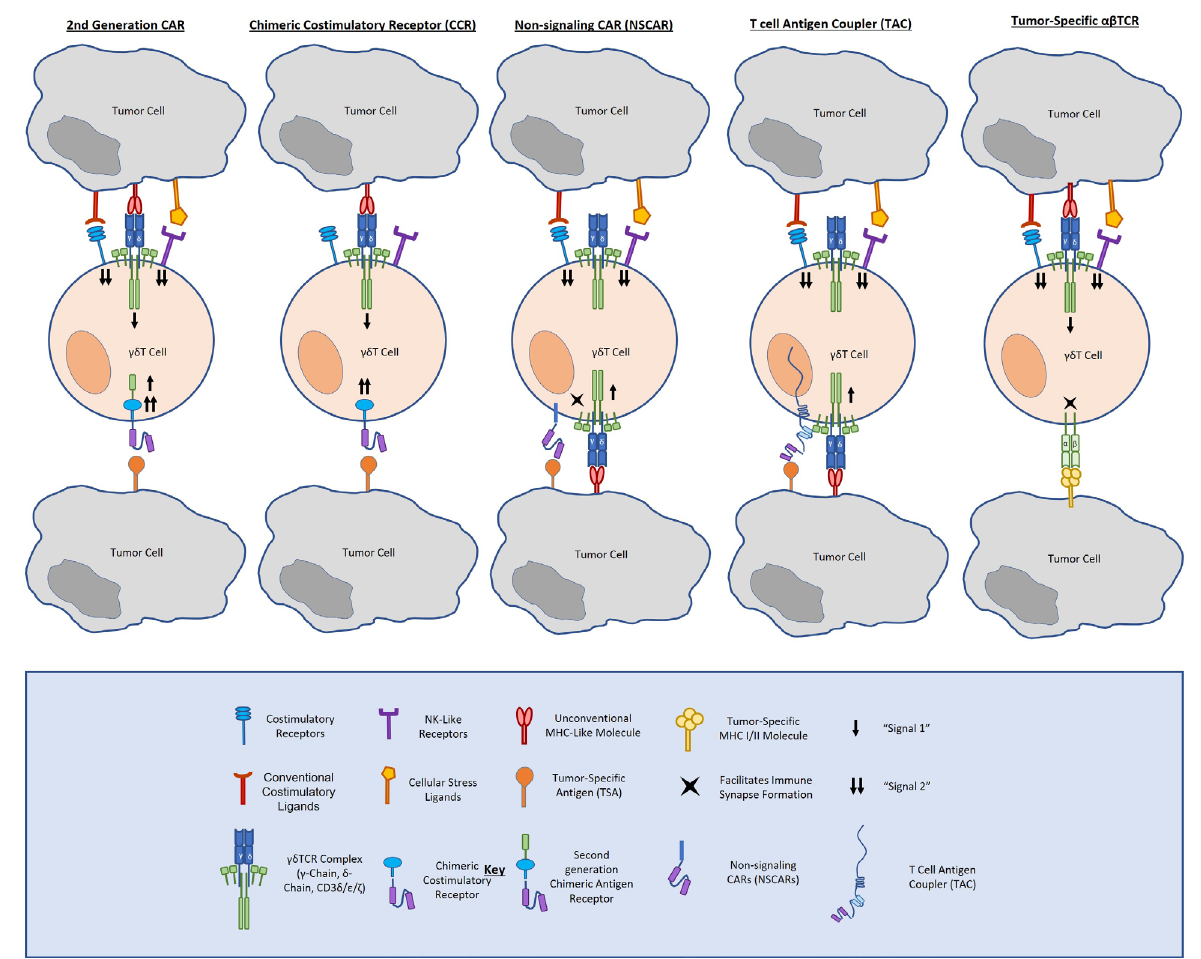
Figure 1. Schematic of the constructs used in engineering of γδ T cells